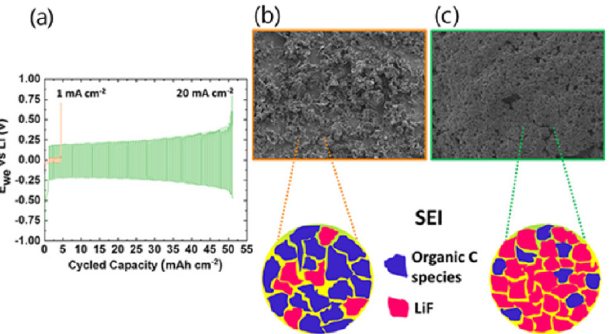
Figure 4. ( a ) Form of symmetric voltage for various current densities; ( b ) SEM picture of accumulated lithium at 1 mA cm − 2 ; ( c ) micrograph of accumulated lithium at 20 mA cm − 2 [68].